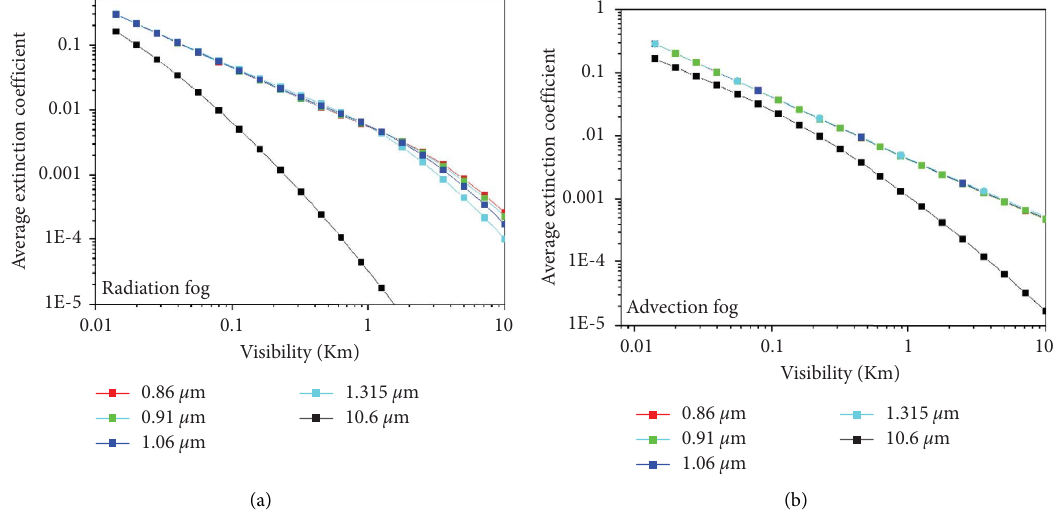
Figure 2: Average extinction coefcient versus